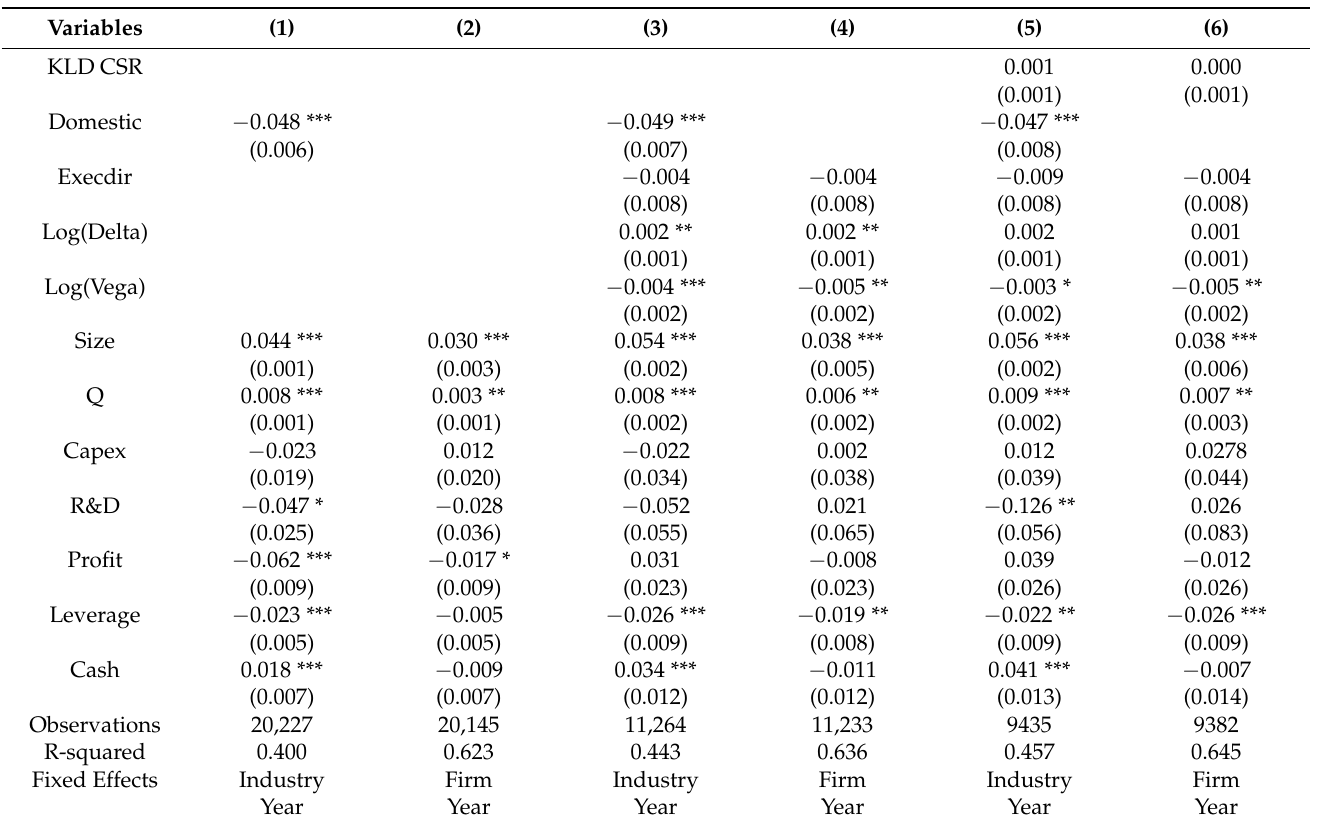
Table 3. Reputational risk index determinants. The dependent variable is the reputational risk index (RRI) in year t + 1. See Appendix A for variable definitions. Standard errors are clustered by firm and reported in parentheses. *, ** and *** represent statistical significance at the 10%, 5%, and 1% level,